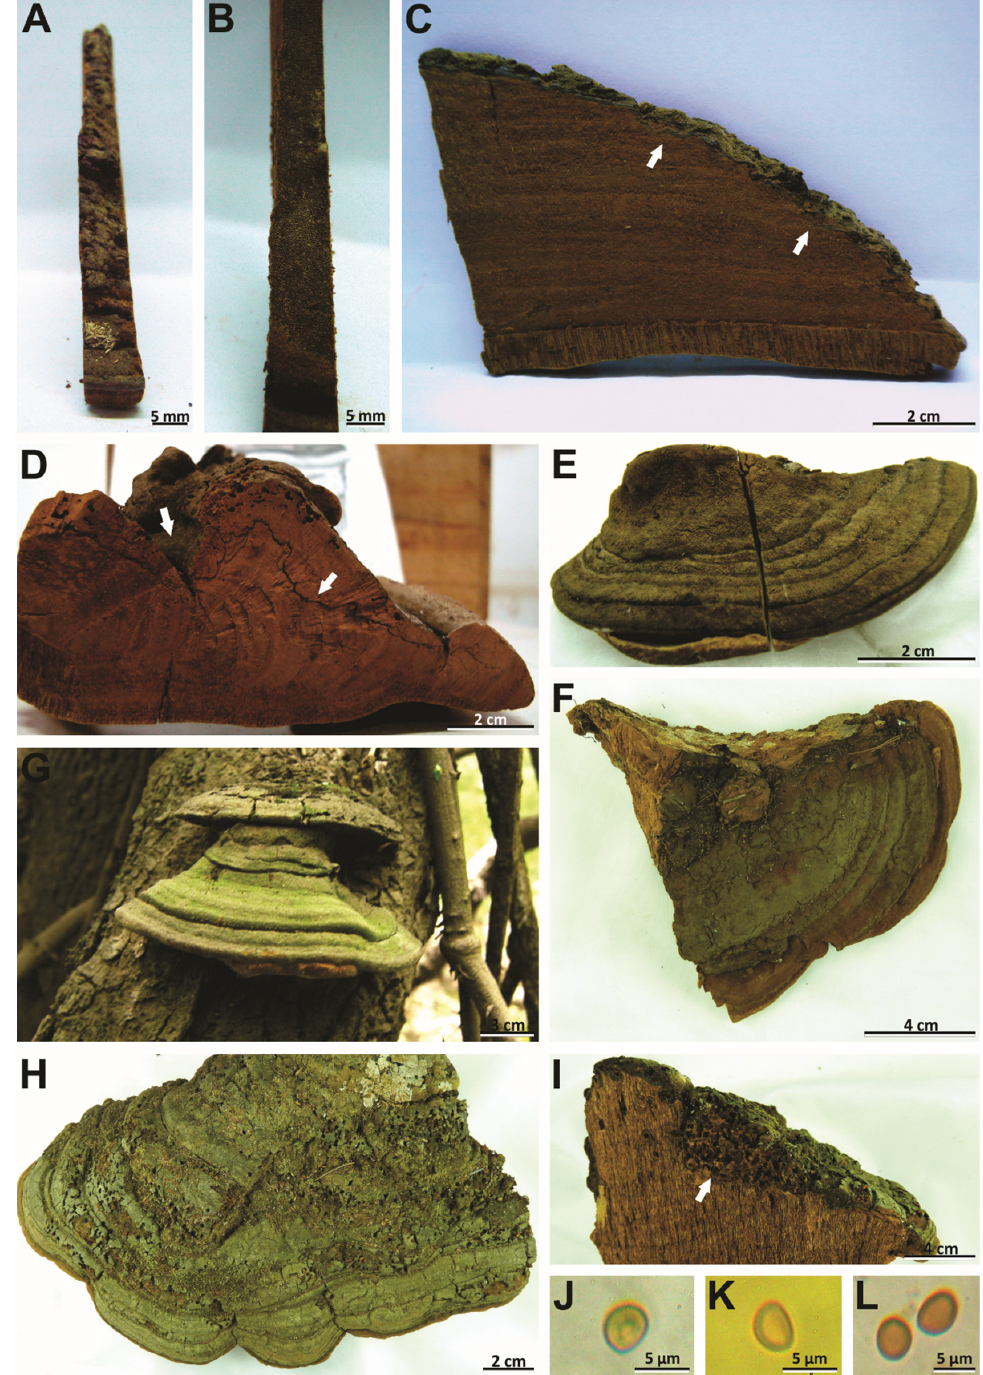
Figure 5. Morphological features of Phellinotus piptadeniae . ( A – C ) F 15071 (isotype). ( A ) pileal surface; ( B ) pore surface; ( C ) perennial basidioma with a dark line in the context and tubes distinctly stratified. ( D ) IAC 4365 (paratype): perennial basidioma with detail of the deep furrows on the lobulate pileal surface, a dark line in the context and tubes distinctly stratified. ( E ) URM80768: young specimen with pubescent, ondulate, slightly zoned, and brown pileal surface. ( F ) FLOR 39572: specimen with slightly cracked pileal surface. ( G ) MVH C5751: specimen with slightly lobulate pileal surface. ( H – I ) FLOR 39572: well-developed specimen with cracked, lobulate and olive gray pileal surface, and a dark line in the context and tubes distinctly stratified. ( J – L ) Basidiospores (F 15071, isotype); ( J ) in water; ( K ) in Melzer’s reagent. ( L ) in